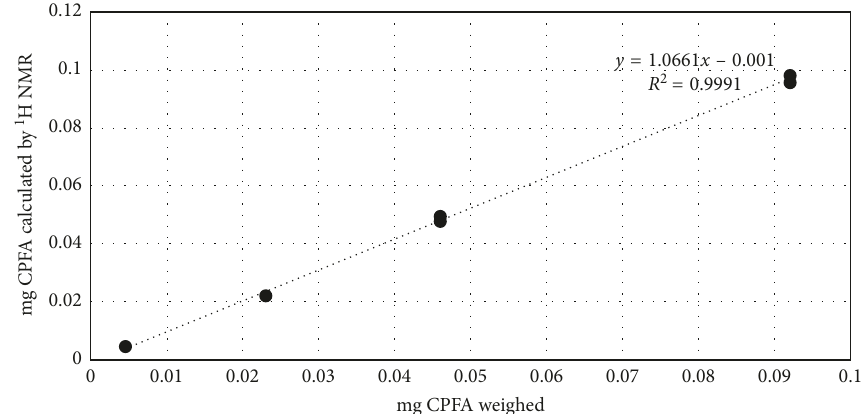
Figure 3: Regression curve for CPFA standard solution measured with the 1 H NMR method.